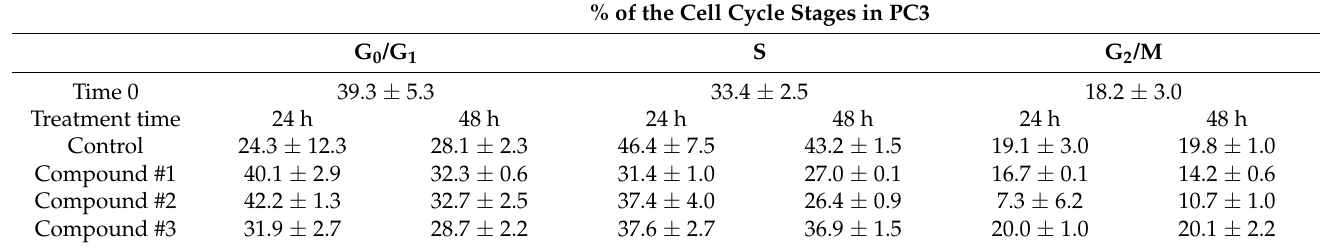
Table 7. Averages ± SD of the measured percentages of the cell cycle in PC3 24- and 48 h post- treatment with control (vehicle), compound #1, compound #2, and compound #3. Pre-G0/G1 figures are